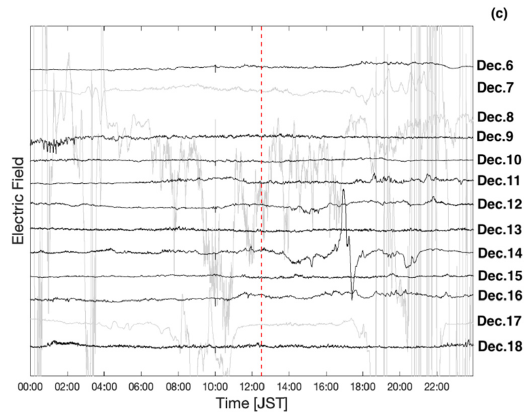
Figure 7. Daily time series of the AEF from 6 days before to 6 days after EQ2 on 12 December: ( a ) Chofu (CHF), ( b ) Kakioka (KAK), and ( c ) Iwaki (IWK). Heavily disturbed days due to bad local weather conditions are shown as gray curves.